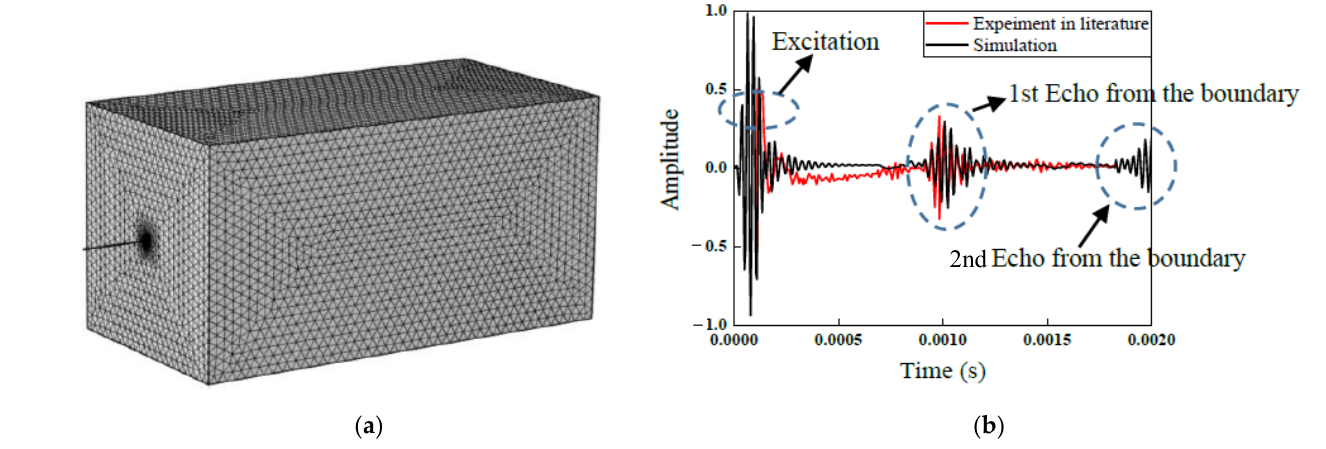
Figure 2. Calibration of the FE model. ( a ) Meshing of the rod embedded in concrete. ( b ) Comparison of signals with the literature.